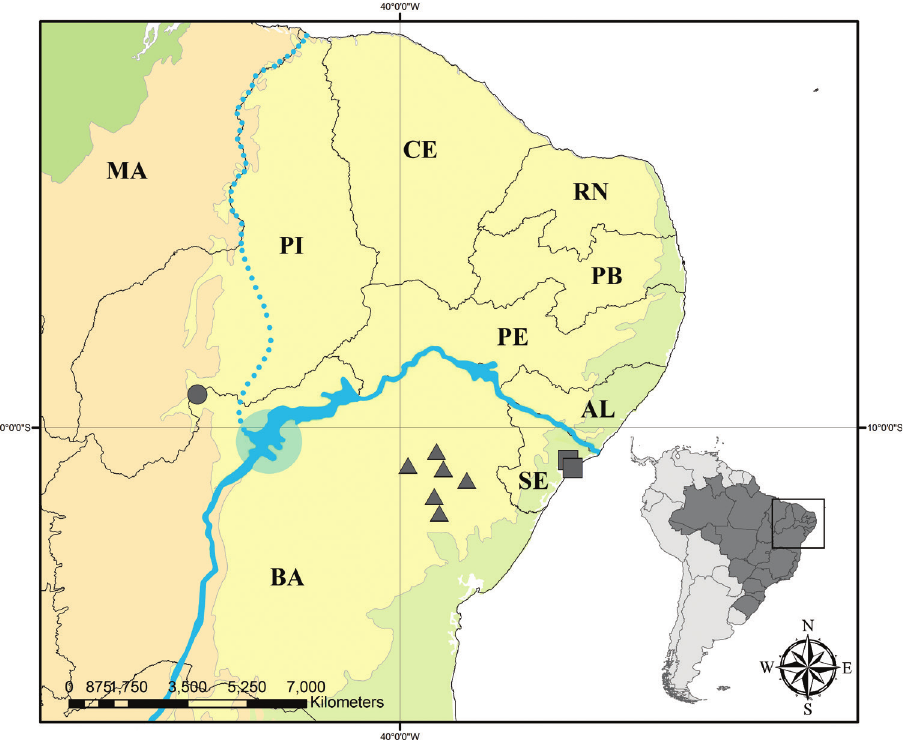
Figure 11. Distribution map of Mcvaughia : triangle – M. bahiana , circle – M. piauhiensis , and square – M. sergipana . Solid blue line in the center represents the São Francisco River today. Dotted blue line represents the past course of São Francisco River. Blue circle represents the São Francisco paleo lake. Light green – Atlantic Forest domain, dark green – Amazon Forest domain, orange – Cerrado domain, and yellow – Caatinga domain. AL – state of Alagoas, BA – state of Bahia, CE – state of Ceará, MA – state of Maranhão, PB – state of Paraíba, PE – state of Pernambuco, PI – state of Piauí, RN – state of Rio Grande do Norte, and SE – state of